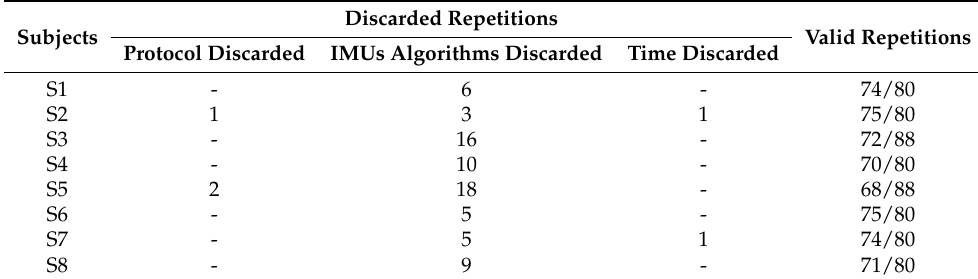
Table 1. Table with the discarded repetitions for each subject, according to the specified criteria: if there were failures in the protocol, if the algorithm mislabeled any repetition, or if in the labeled repetition there was not enough monotonous walk time.